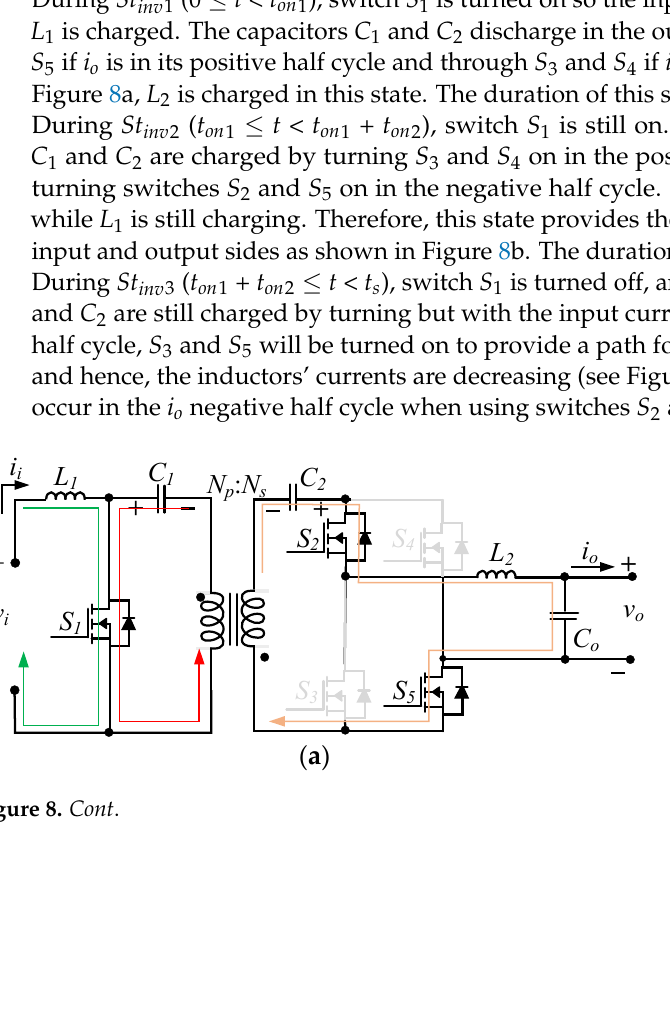
Figure 7. MCI as a DC/DC converter: ( a ) St dc 1 and ( b ) St dc 2 .